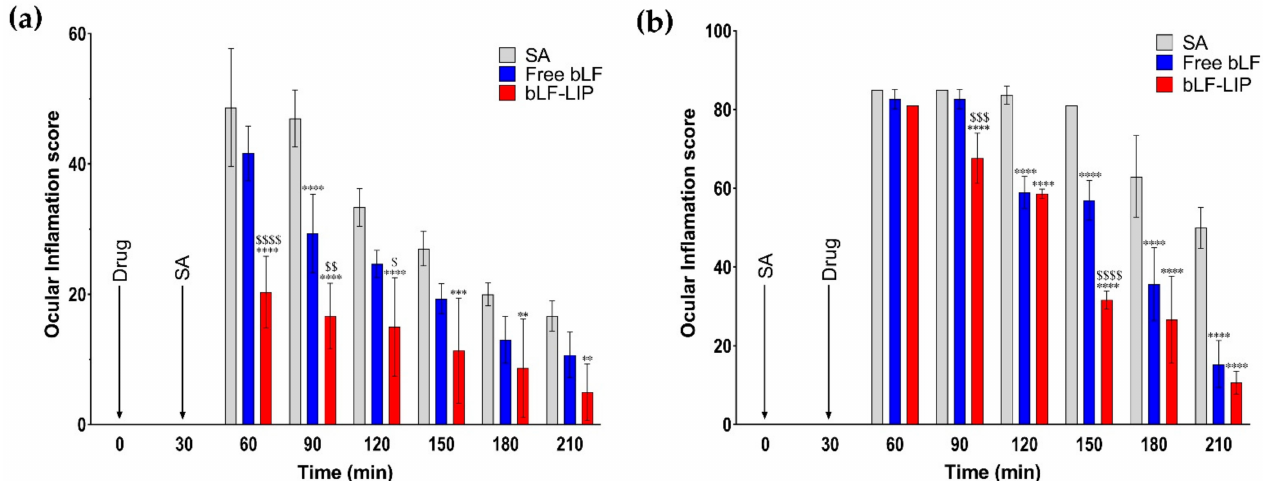
Figure 9. ( a ) Ocular inflammation prevention. ( b ) Ocular inflammation treatment test. Values are expressed as mean ± SD; * p < 0.05, ** p < 0.01 and *** p < 0.001 and **** p < 0.0001 significantly lower than the inflammatory effect induced by SA; $ p < 0.05, $$ p < 0.01 and $$$ p < 0.001 and $$$$ p <0.0001 significantly lower than the inflammatory effect induced by free